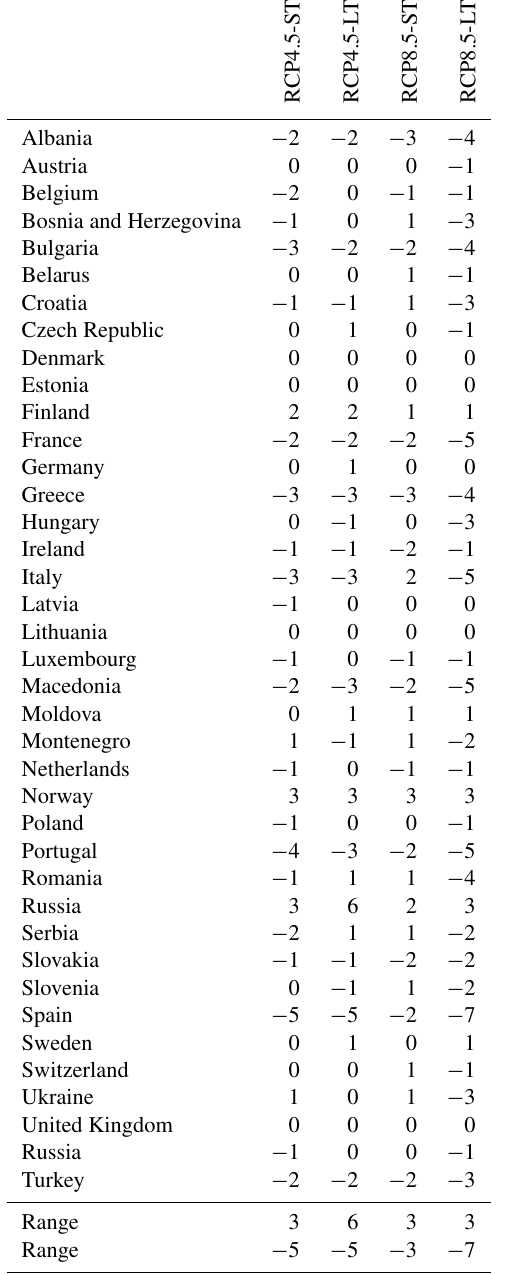
Table 3. Country estimates of water scarcity risk index for emission scenarios RCP4.5 and RCP8.5 in the short term (ST: 2020–2059) and long term (LT: 2060–2099)